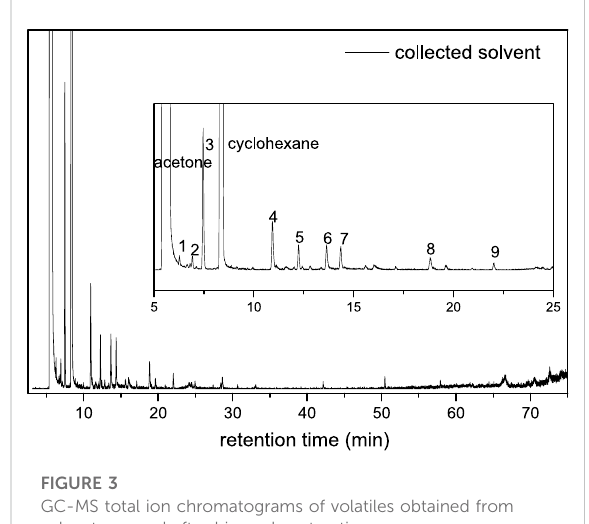
FIGURE 3 GC-MS total ion chromatograms of volatiles obtained from solvent removal after biocrude extraction.